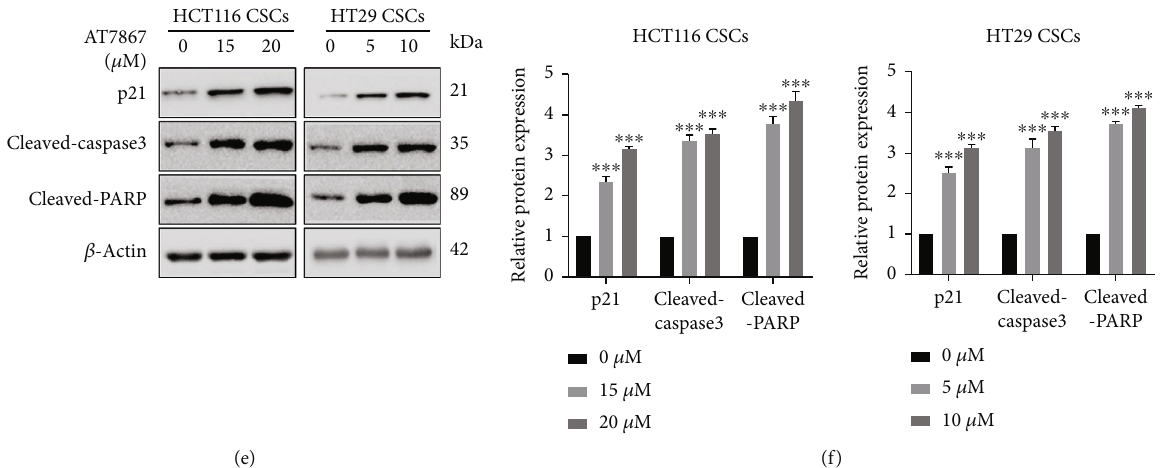
Figure 4: AT7867 inhibits the proliferation of CSCs (a-d) The cell cycle distribution of CSCs treated with AT7867 was analyzed by fl ow cytometry and apoptotic cells were detected by Annexin V-FITC and PI double staining, following treatment of CSCs in di ff erent doses of AT7867 for 24 h. (e, f) Expression of Cleaved-Caspase 3, Cleaved-PARP and p21 was detected by western blotting in CSCs treated with AT7867. ∗ P < 0 : 05 , ∗∗ P < 0 : 01 , and ∗∗∗ P < 0 : 001 vs. the